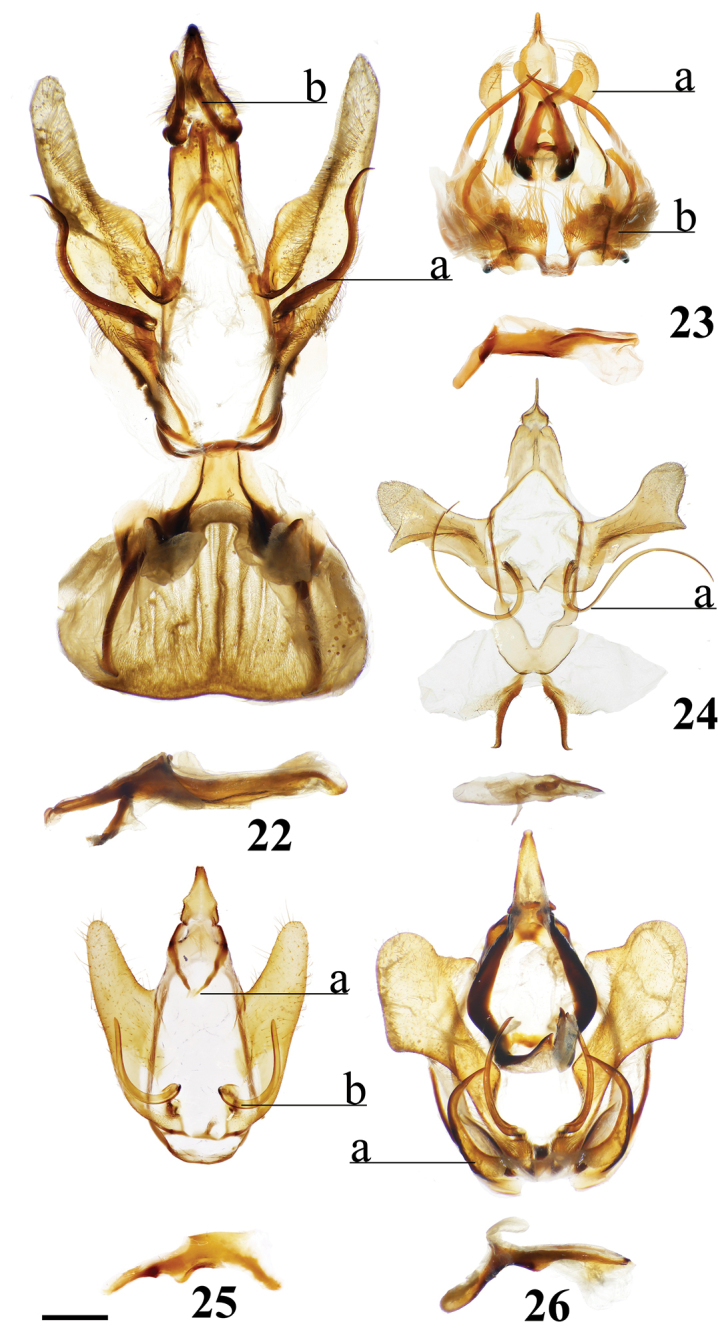
Ventral view of male genitalia of type species of genera belonging to Druenticinae: Druenticini. Phallus/juxtal complex is figured below the genitalia in the lateral view. 22Druenticapartha, St Laurent diss.: 3-17-18:3 (MGCL) 23Micrallominutus holotype, St Laurent diss.: 10-21-15:1 [reused with permission from St Laurent and Mielke (2016), ZooKeys] (DZUP) 24Ulalumavalva, St Laurent diss.: CPC 7 [reused with permission from St Laurent et al. (2018a), Systematic Entomology] (CRAS) 25Pameaalbistriga syntype, genitalia vial NHMUK 010402302 26Procinnuscahureli, genitalia vial NHMUK 010402314. Scale bar: 1 mm.